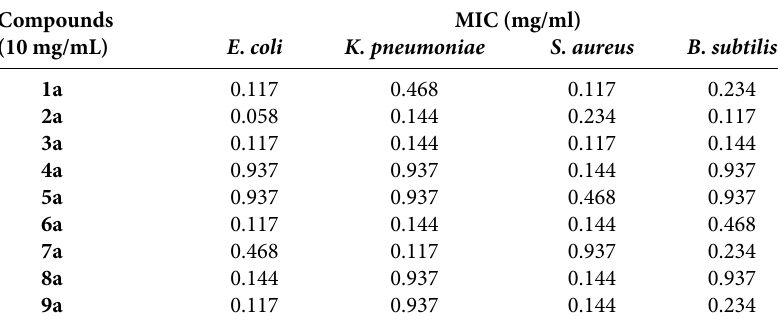
Table 3. MIC (minimum inhibitory concentration in mg/mL) of the synthesised compounds Compounds